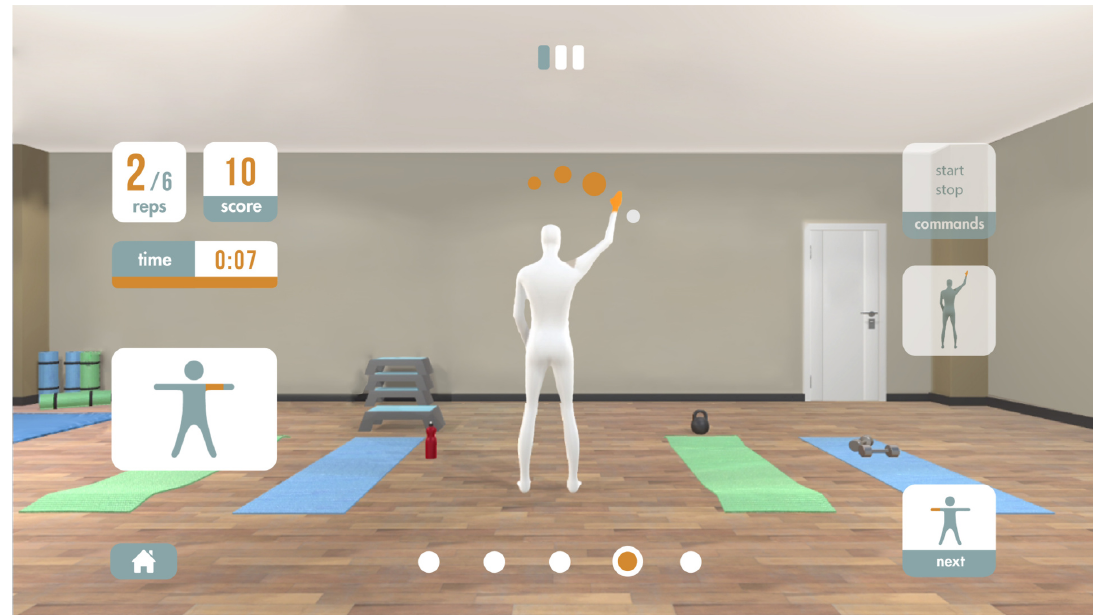
Figure 6. Visual aspect of the graphical user interface for the patient after the integration of some improvements. The feedback was obtained from the questionnaires completed by patients and